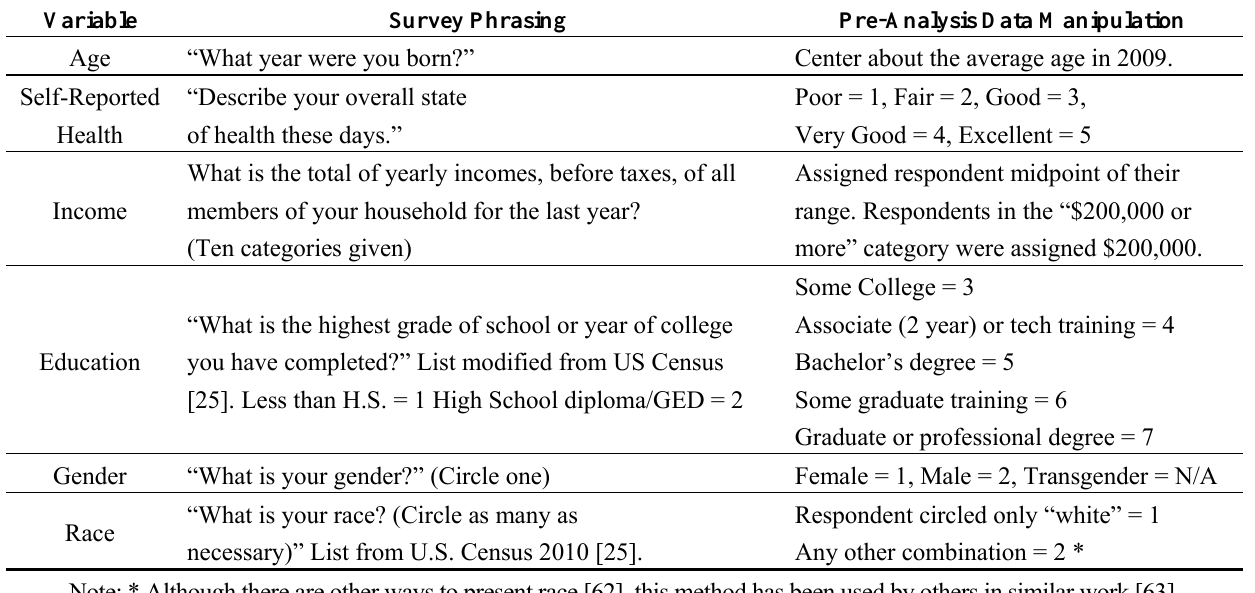
Table 4. Explanatory variables: demographics and individual perceptions (from Survey).